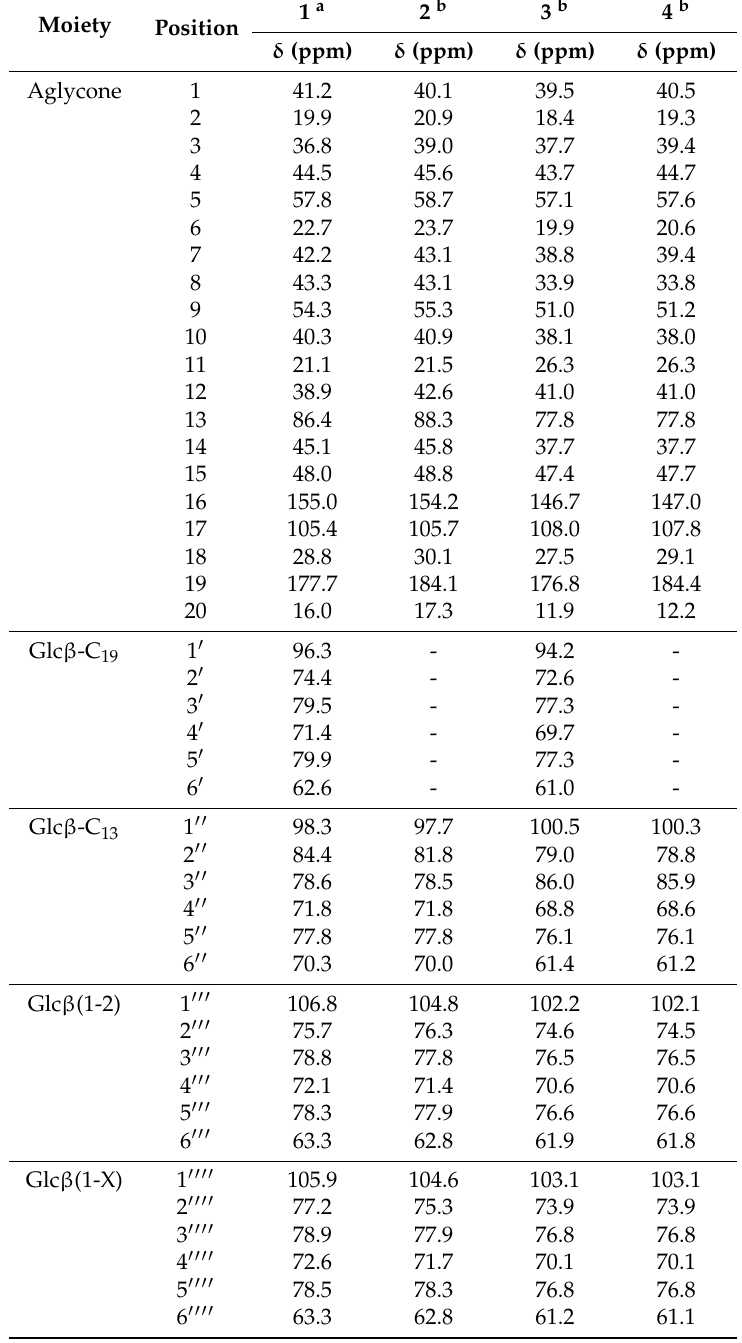
Table 2. 13 C chemical shifts of diterpene glycosides 1 – 4